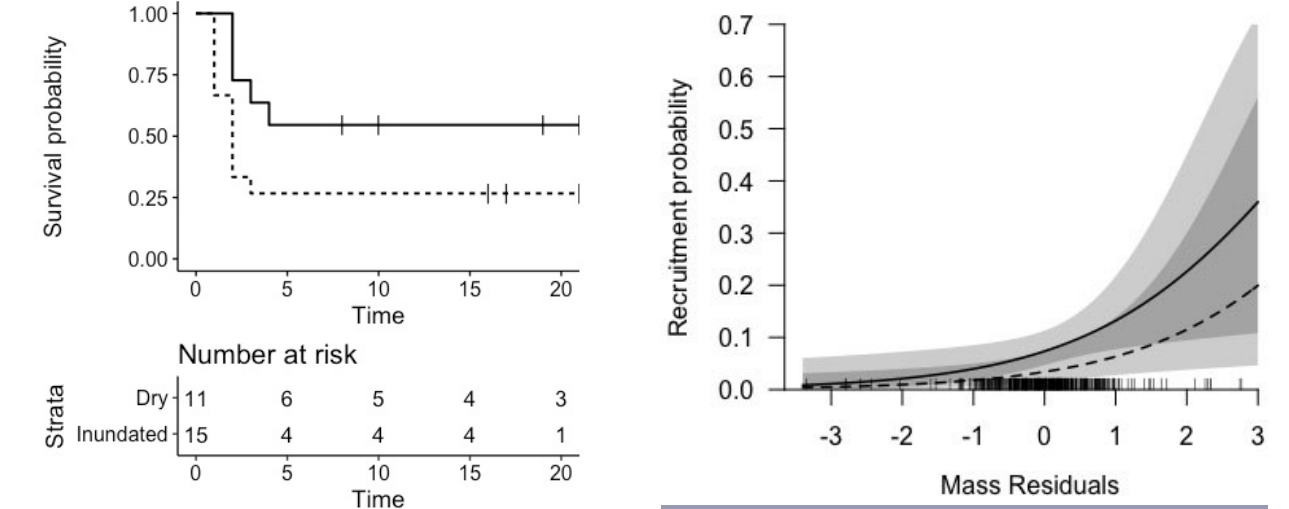
Fig. 3 . Plot illustrating the relationship between nestling condition (residuals from a mass-tarsus regression) and local recruitment of Yellow Warblers ( Setophaga petechia ), which fledged from territories within the drawdown zone of the Upper Arrow Lakes Reservoir in British Columbia, Canada, that were inundated (dashed line) or not inundated (solid line) by water. The shaded areas are 95% confidence bands, with the darker area showing the region in which the confidence intervals overlap. The rug plot along the x-axis shows the distribution of the covariate